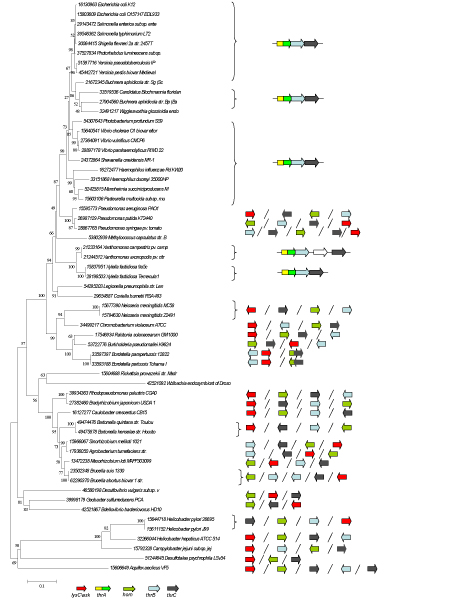
Gene organization of threonine genes. Structure and organization of threonine biosynthetic genes of the 58 proteobacteria correlated with their phylogenetic position as established by RpoD analysis.